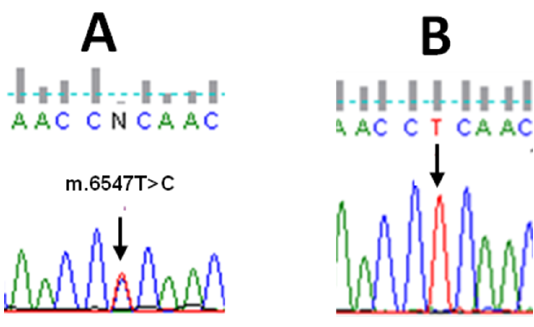
Figure 5. (A) Electropherogram showing the m.6547T>C in patient 3; (B) Electropherogram of his mother.